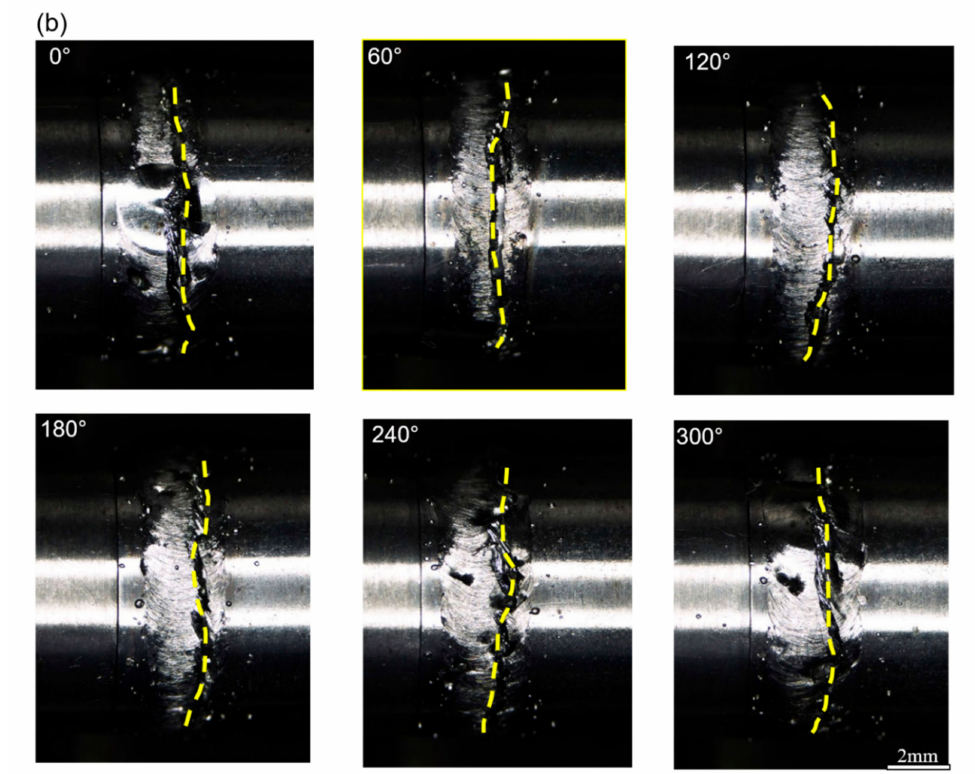
Figure 12. Views of the failure path of weld joints: ( a ) 250 J / cm; ( b ) 3600 J /